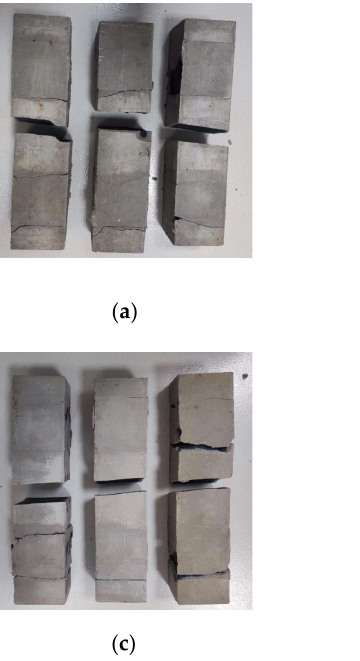
Figure 14. Twenty-eight day compressive damage of geopolymer specimens with different alkali activator content. Content of alkali activator %: ( a ) NaOH: 2%; ( b ) NaOH: 3.5%; ( c ) Na 2 SiO 3 : 0%; ( d ) Na 2 SiO 3 : 3%.